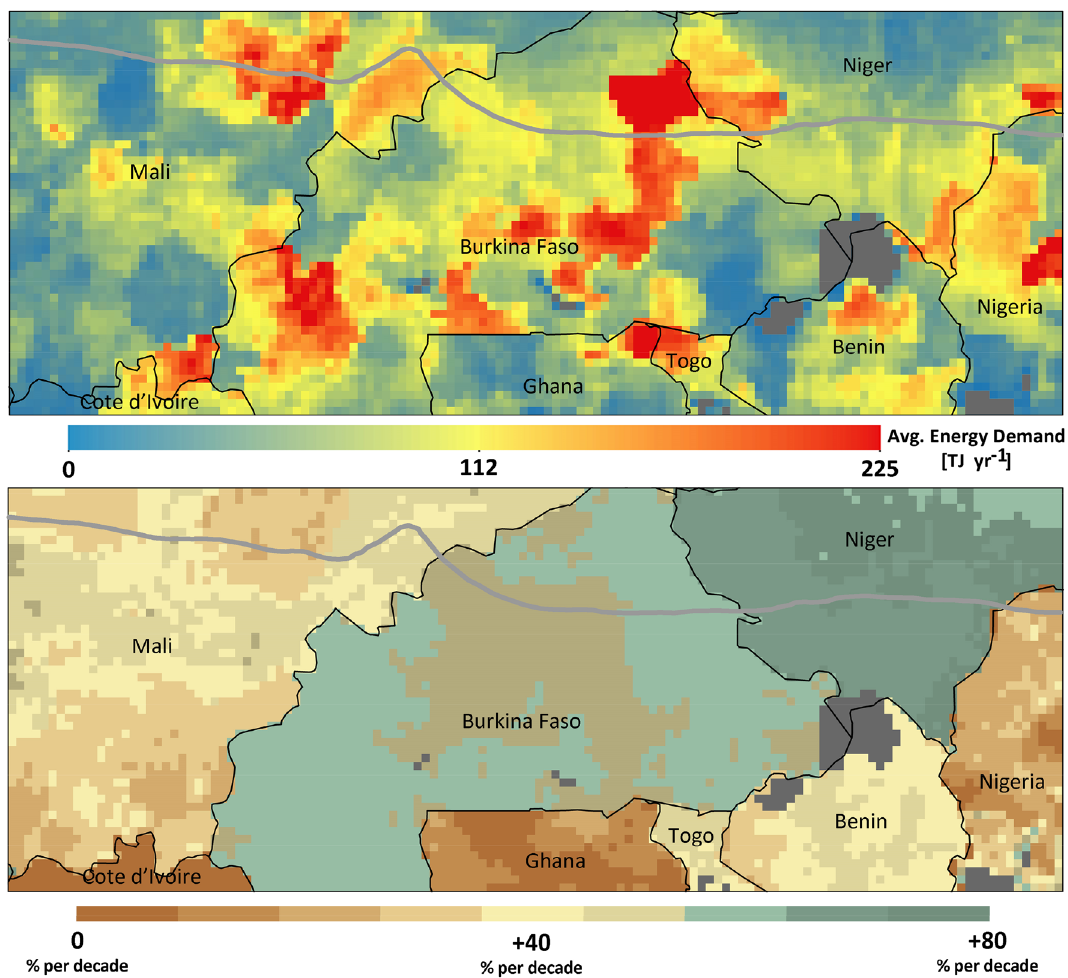
Figure 3. Average annual livestock energy demand (Terajoule (TJ) ME yr −1 ) and its trend during the historical period of 1981 to 2020. Figures were generated using ArcGIS 10.8.1 (https:// www. esri. com/ en- us/ arcgis/ produ cts/ arcgis- pro/ overv